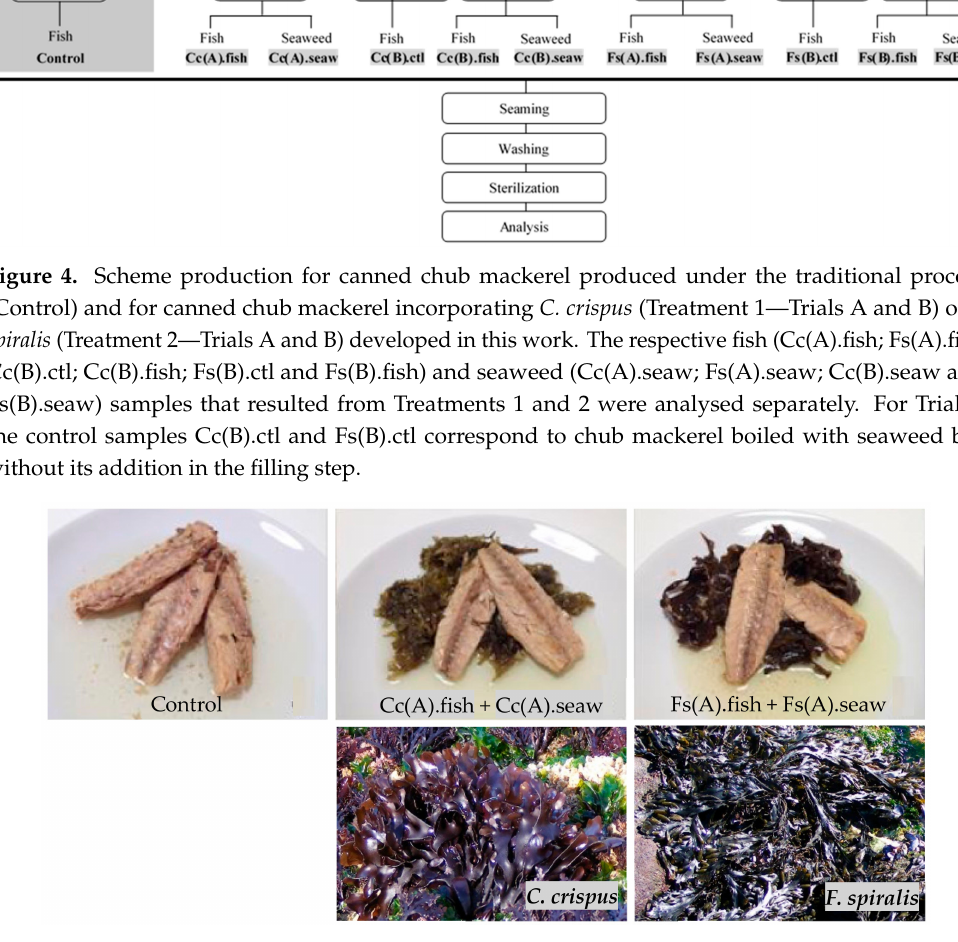
Figure 5. Samples of canned chub mackerel produced under the traditional process (Control) and canned chub mackerel incorporating C. crispus prepared under the Treatment 1, Trial A conditions (Cc(A).fish + Cc(A).seaw) or incorporating F. spiralis prepared under the Treatment 2, Trial A conditions (Fs(A).fish + Fs(A).seaw) (see Figure 4 for identification of samples). The bottom images of Figure 5 represent the C. crispus and F. spiralis seaweed species used for the preparation of the canned